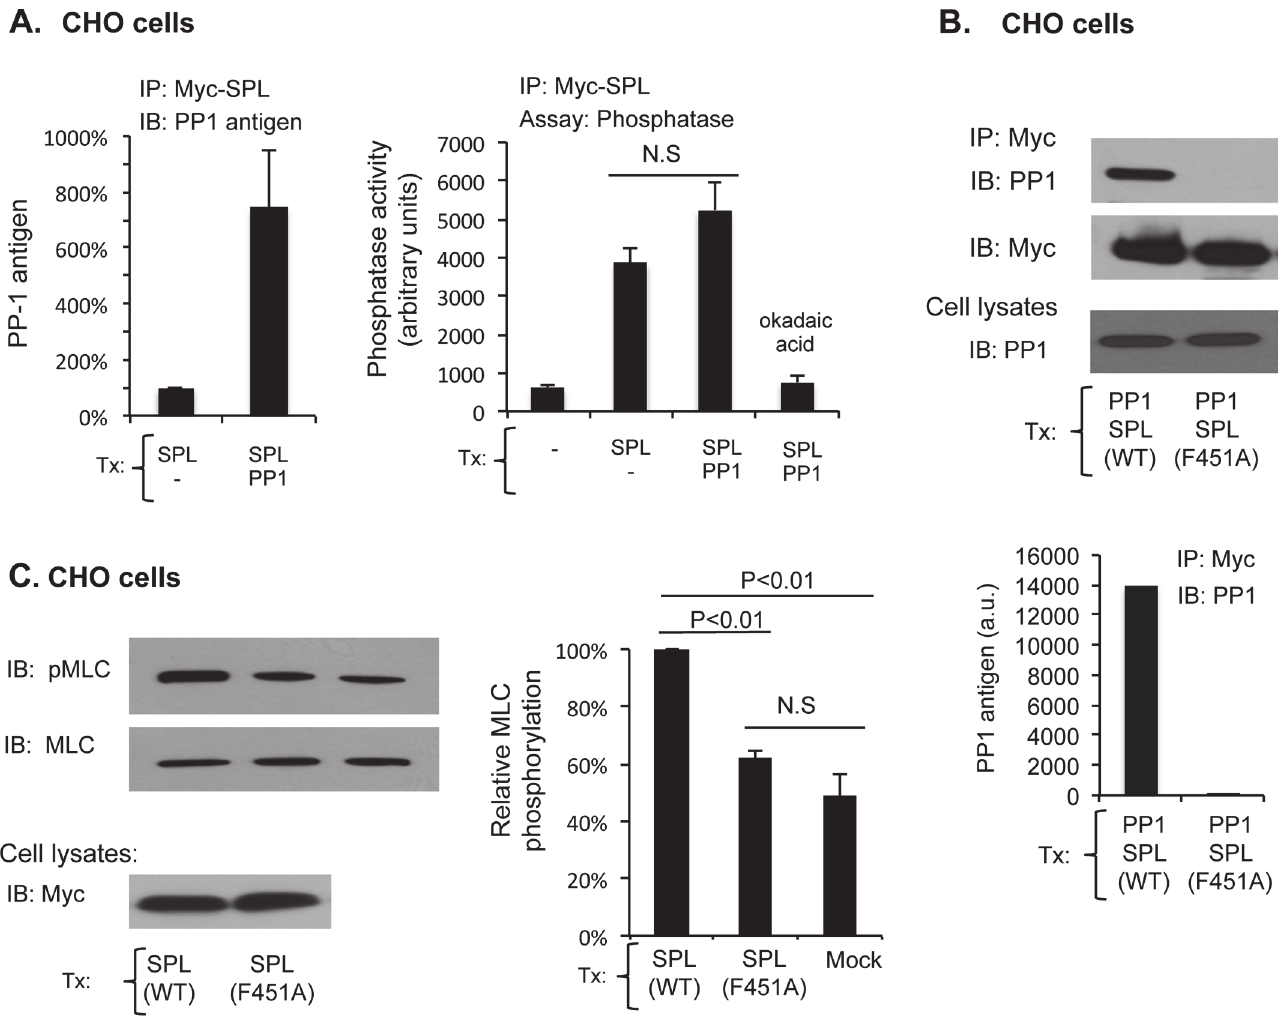
Fig 6. Binding to spinophilin inhibits PP1. (A) CHO cells were transfected with Myc-SPL and Flag-PP1 α as indicated. Proteins were precipitated with anti- Myc and then probed with anti-PP1 ( left ) or assayed for SPL-associated phosphatase activity with a small molecule substrate ( right ) (mean ± SEM, N = 3). (B) CHO cells were transfected with PP1 α and either Myc-tagged wild type or Myc-tagged F451A spinophilin as indicated. After immunoprecipitation with anti-Myc, precipitated proteins were probed with anti-PP1 and anti-Myc (mean ± SEM, N = 3). (C) Top and right . CHO cells were transfected with either wild type or F451A spinophilin and then immunoblotted for MLC and pMLC as indicated (mean ± SEM, N = 3). Bottom . Cell lysates were immunoblotted with anti- Myc, demonstrating equal expression of wild type and F451A